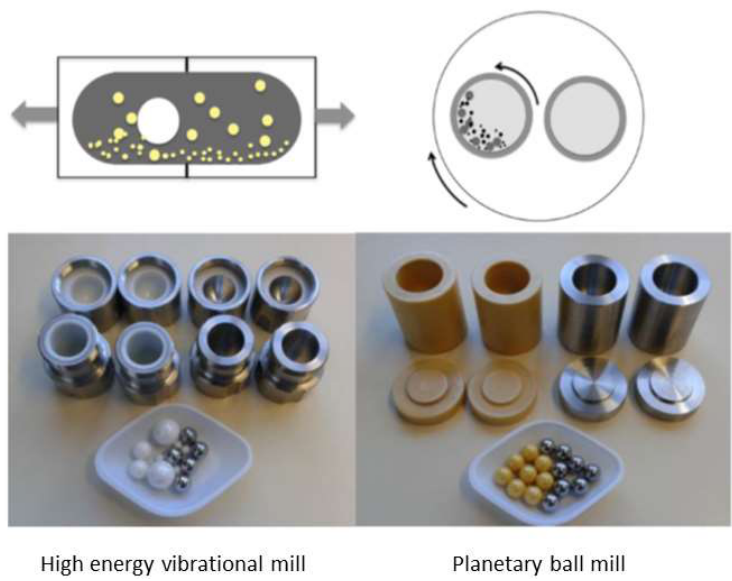
Figure 2. Most commonly used ball-milling equipment and milling media: High-energy vibrational mill: ( top ) Shaking direction, ( bottom ) ZrO 2 and stainless-steel milling jars (10 mL) and balls. Planetary ball mill: ( top ) Movement description, ( bottom ) ZrO 2 and stainless-steel milling vessels (12 mL) and balls. Adapted with permission from Reference [41]. Copyright (2017) American Chemical Society.